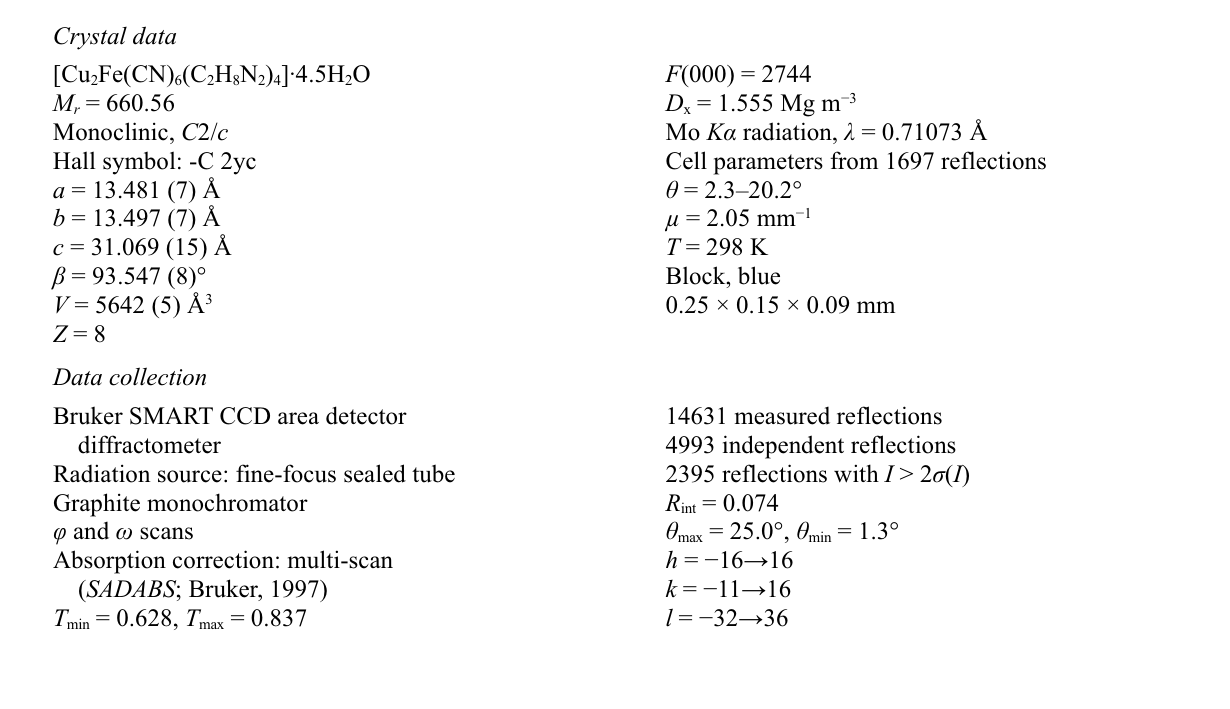
Figure 3 Crystal packing of (I), showing the hydrogen-bonded interactions as dashed lines. catena -Poly[[[ µ -cyanido-1:2 κ 2 C:N-tricyanido-1 κ 3 C - bis(ethylenediamine)-2 κ 4 N,N ′ -copper(II)iron(II)]- µ -cyanido- κ 2 C:N- [bis(ethylenediamine- κ 2 N,N ′ )copper(II)]- µ -cyanido- κ 2 N:C]